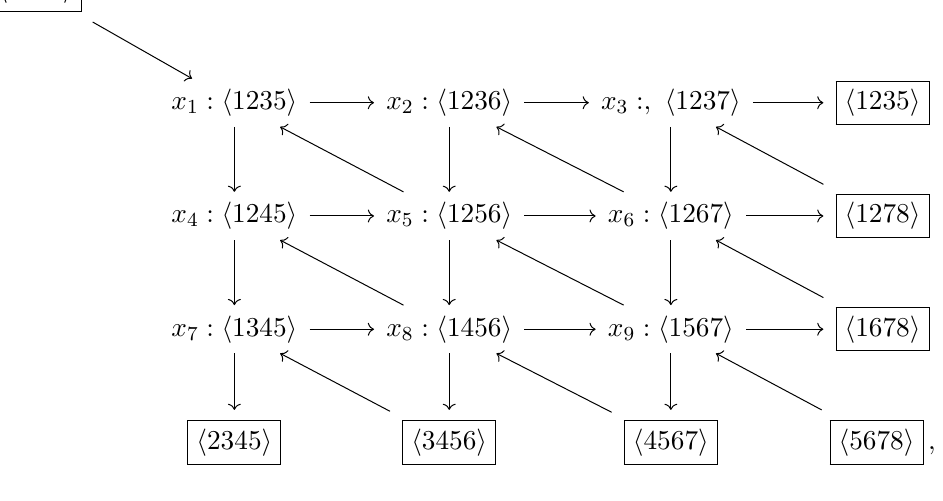
Figure 10. The initial quiver for the Gr (4 , 8) cluster algebra